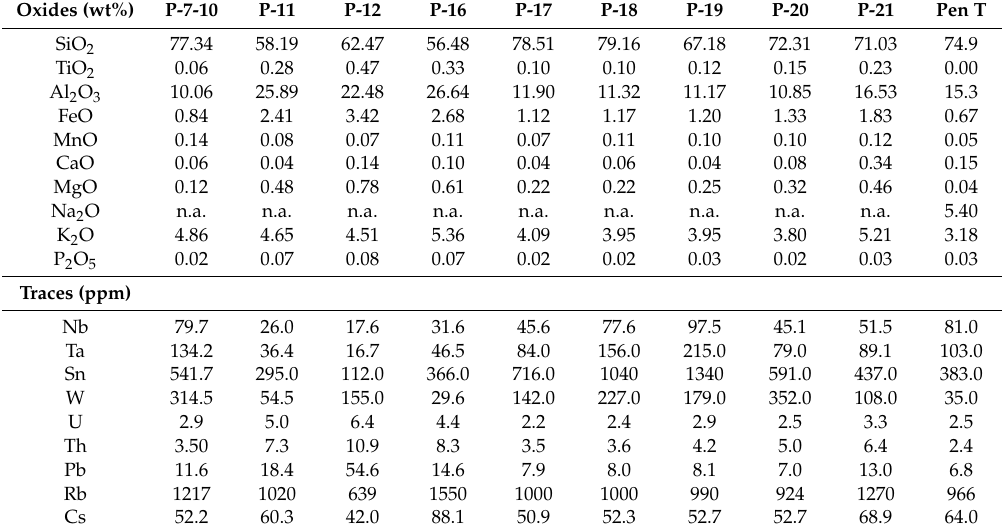
Table 1. Comparison of the chemical composition of samples from the Penouta tailings (Balsa Grande, P-7-10 to P-16; Balsa Pequeña, P-17 to P-21) and the leucogranite outcropping ore (Penouta tailings (Pen T), [45]). N.a.: not analysed.